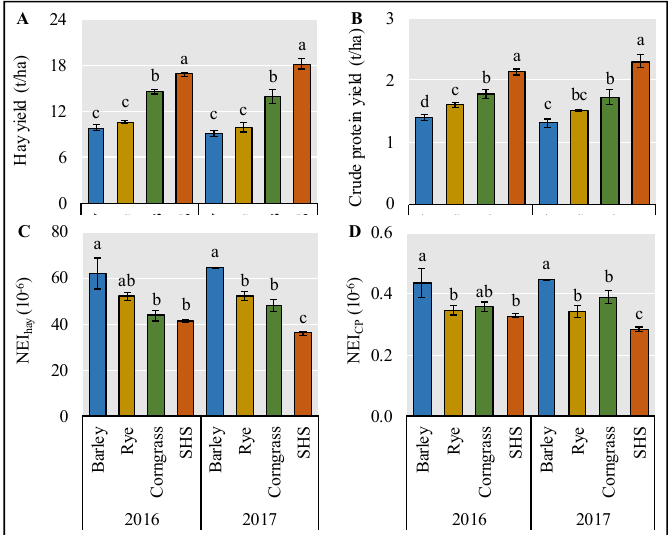
Figure 5. Mean ( ± SE) hay yield ( A ), crude protein yield ( B ), NEI hay ( C ), and NEI CP ( D ) (N 2 O emission intensity, i.e., yield-scaled N 2 O emission) for barley, rye, corngrass, and SHS in 2016 and 2017. For each category and each year, means with the same letters are not significantly different ( P > 0.05).